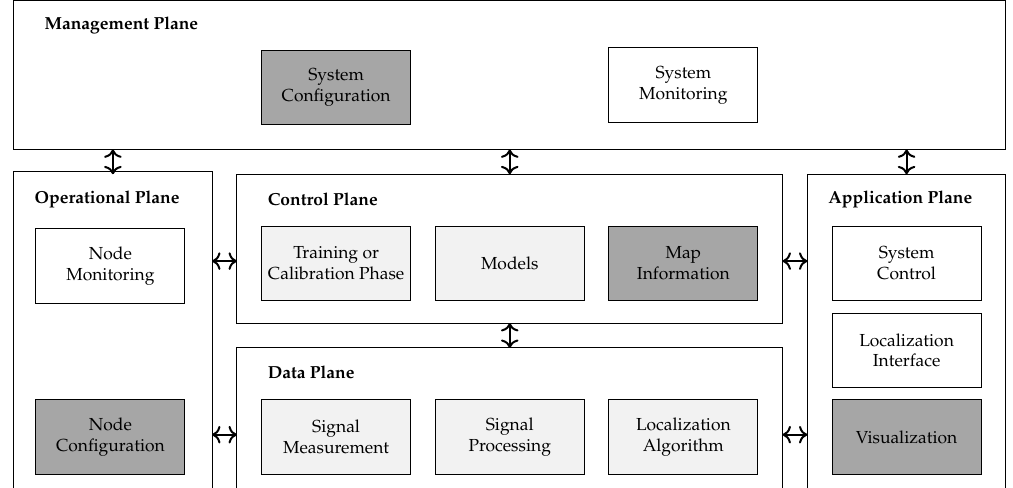
Figure 3. Proposed architectural model. The light gray-filled blocks within the control and data plane are DFL function blocks, covered in research within the last decade. The dark gray-filled function blocks were proposed and implemented in this work. The non-filled function blocks are the subject of current